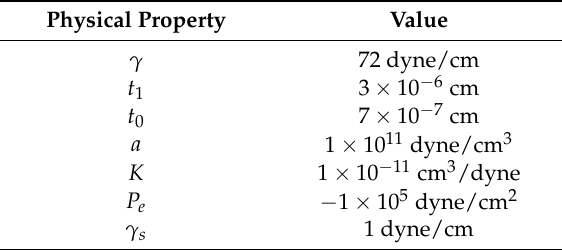
Table 1. Physical properties used for calculation of droplet profile and deformation in the substrate [18]. Physical Property Value γ 72 dyne/cm